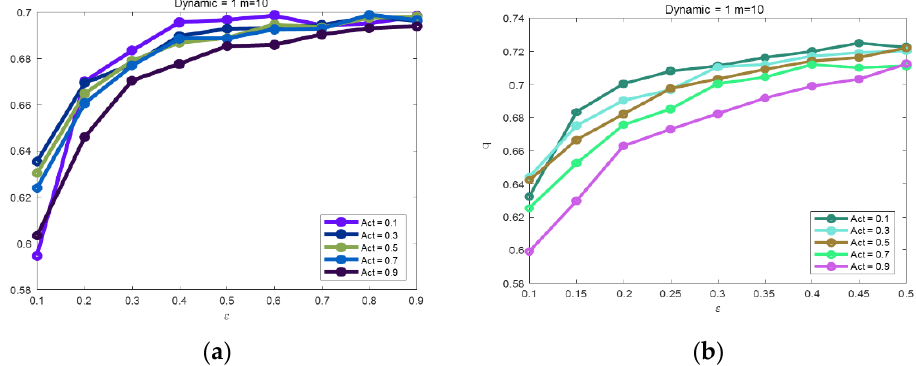
Figure 2. The effect of influence on product demand under different information mastering abilities. ( a ) 𝜙 = 0.8 ( b ) 𝜙 = 0.5 .